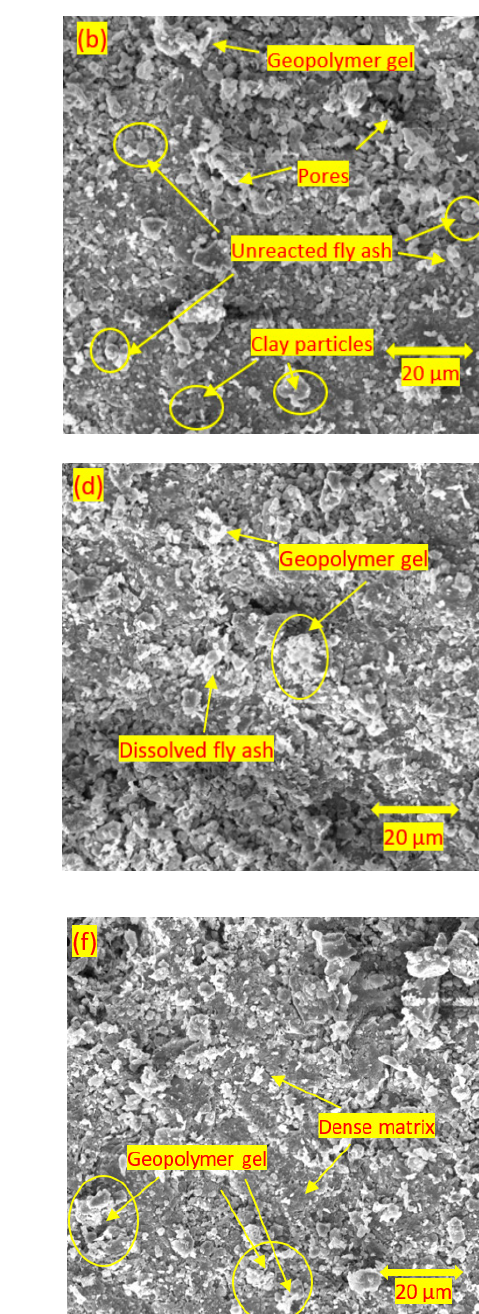
Figure 15. SEM images of soils stabilised with ( a ) 15% fly ash at 1 day of curing; ( b ) 25% fly ash at 1 day of curing; ( c ) 15% fly ash at 7 days of curing; ( d ) 25% fly ash at 7 days of curing; ( e ) 15% fly ash at 28 days of curing; and ( f ) 25% fly ash at 28 days of curing at 20 μ m.